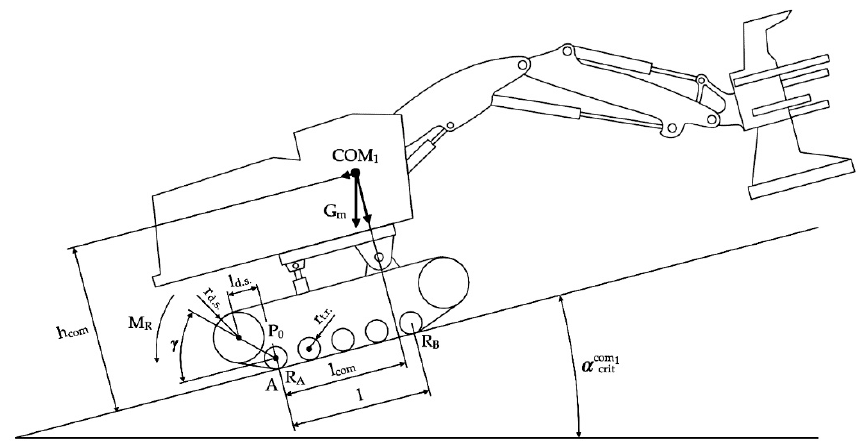
Figure 3. Calculation scheme of forces on a tracked feller-buncher when driving uphill.